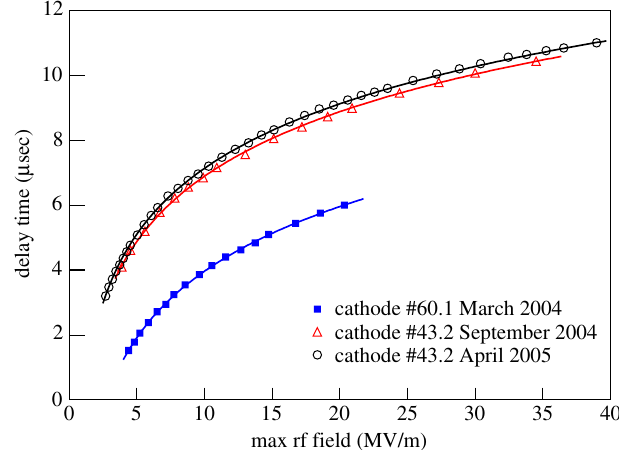
FIG. 9. (Color) Measured delay time ( t ) between the end of rear the rf pulse and the beginning of the multipacting spike as a function of the maximum rf field amplitude for two cathodes (No. 60.1 and No. 43.2 [24]), with fits to Eq. (4). The solenoid currents for these measurements were 400 A in the main sole- noid and 30.5 A in the bucking solenoid.